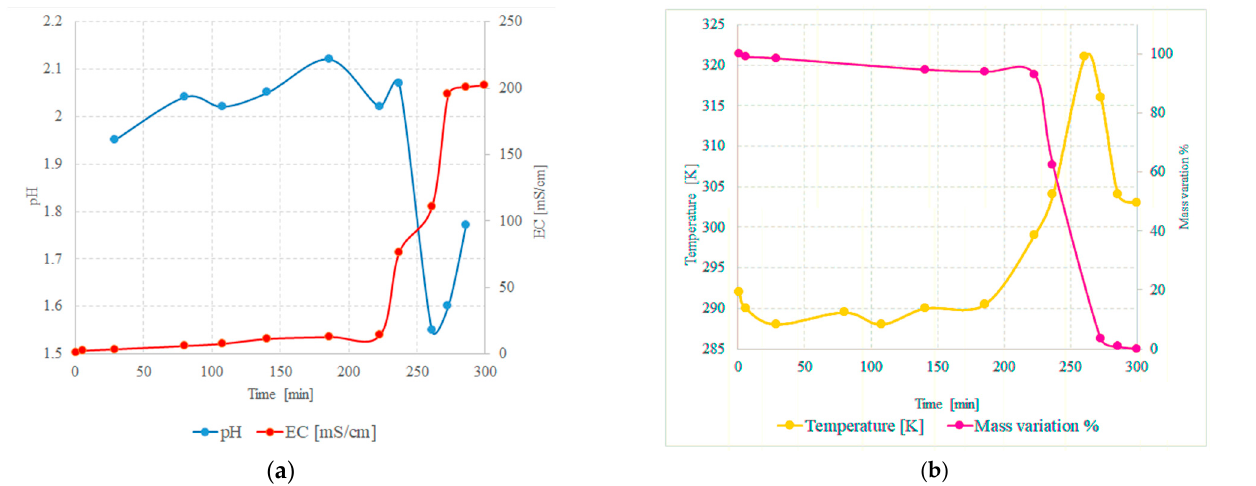
Figure 5. ( a ) pH and electroconductivity of solution during the dissolution process and ( b ) temperature and mass variation dependence on time during the same process.